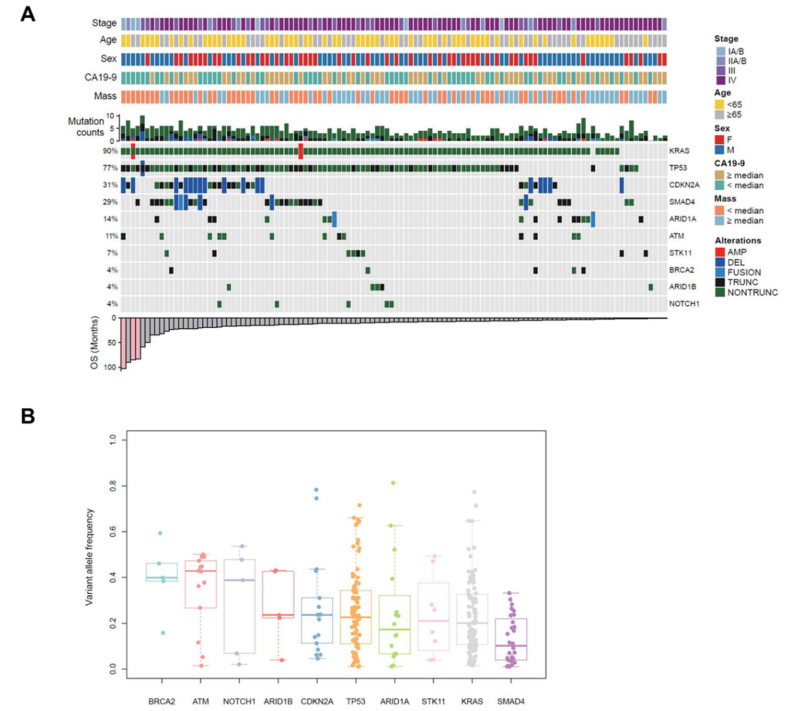
Figure 4. Landscape of genomic alterations identified by targeted deep sequencing in EUS-FNB specimens of patients with PDAC. ( A ) Co-mutation plot displaying integrated genomic data for 116 EUS-FNB specimens displayed as columns, including somatic mutations and somatic copy number variations for significantly mutated genes listed at the right (Top 10). The percentage of PDAC samples with an alteration of any type is noted at the left. Stage, age, sex, CA19-9 level, tumor mass size, and the number of any genetic alterations per each sample is presented on the top. Overall survival (OS) of each patient is shown on the bottom. ( B ) Variant allele frequency (VAF) distributions are analyzed, and median values are indicated by the central bar in the box and whiskers plots. PDAC, pancreatic ductal adenocarcinoma; EUS-FNB, endoscopic ultrasound-guided fine-needle biopsy; AMP, copy number amplification; DEL, copy number deletion; FUSION, structure variation; TRUNC, truncating mutation; NONTRUNC, non-truncating